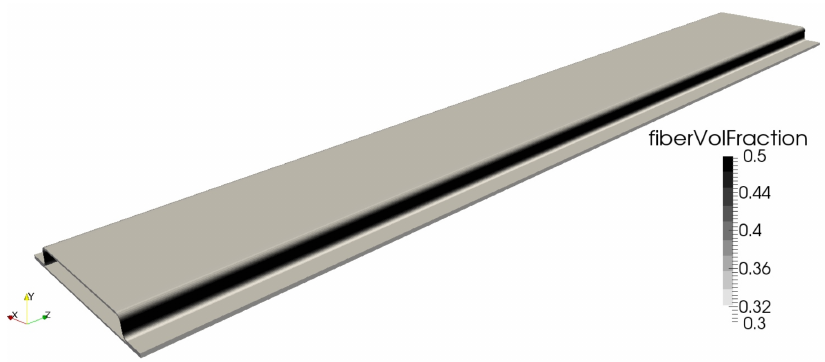
Figure 14. Fiber volume fraction of the sandwich part at the beginning of the simulation.